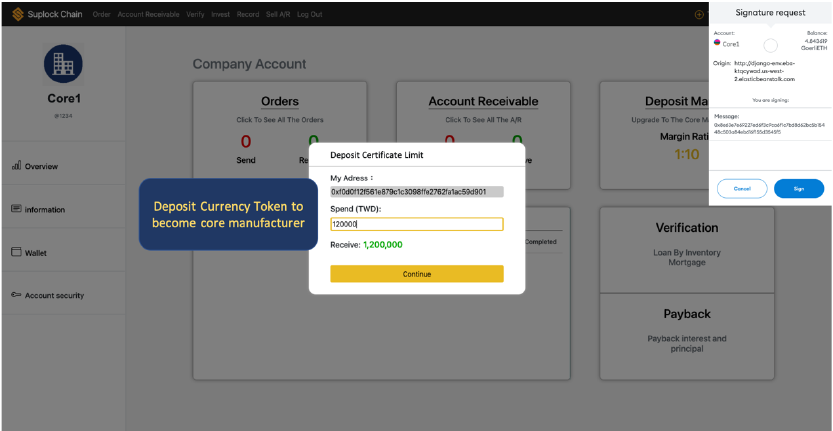
Figure A1. Module for company depositing credit and deploying smart contracts. Core1 requests to deploy smart contract on blockchain.